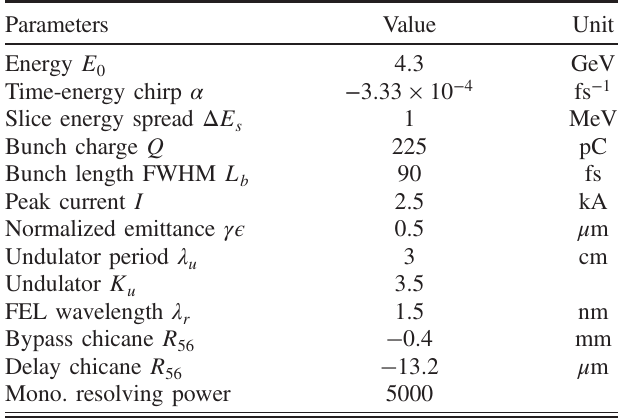
TABLE I. Main electron and radiation parameters.